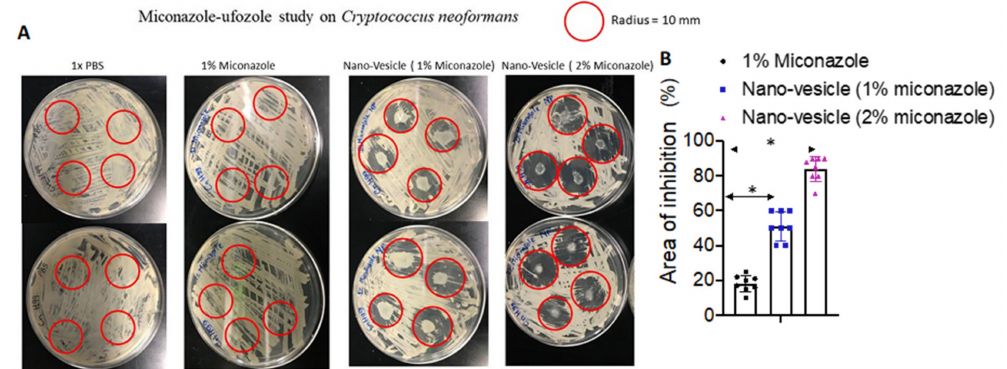
Figure 5. Fungal growth inhibition using free miconazole, as well as nano-vesicles at 1% and 2% miconazole. PBS was used as a control. ( A ) Significantly higher levels of inhibition were expressed using nano-vesicles as opposed to free miconazole, supporting the notion that nano-vesicles act as an inhibition enhancer. ( B ) Around 20% and 40% total fungal colonies were inhibited after 48 h with the miconazole nano-vesicles 1% and 2% treatment compared to PBS treated petri dishes, respectively. All data are presented as mean ± SE ( n = 8). * p < 0.05 compared with the Actavis.